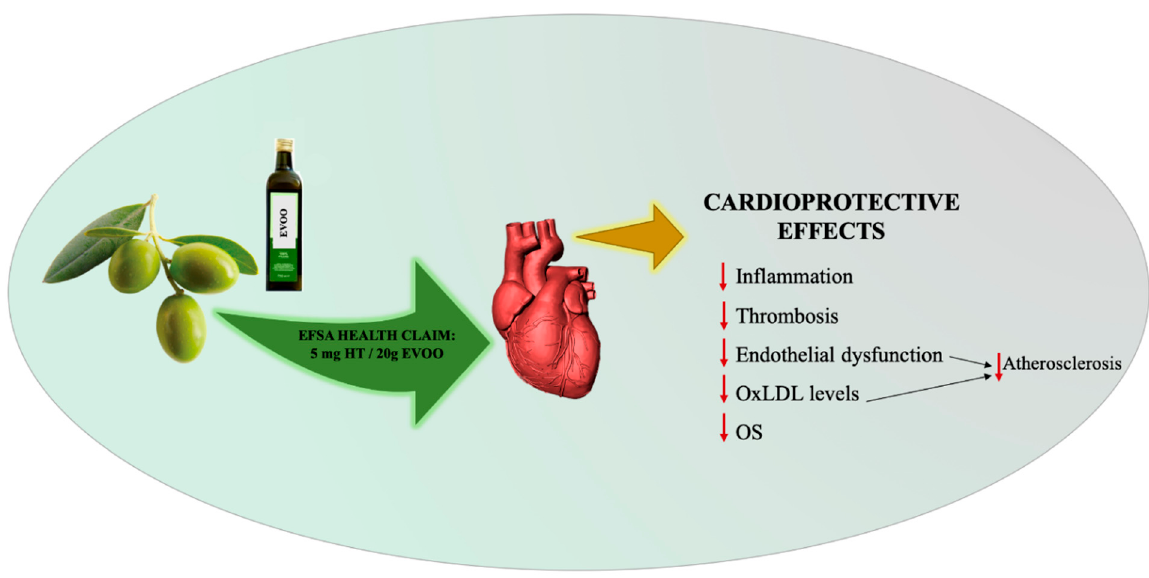
Figure 4. EVOO and its cardioprotective action on the CV system. EVOO, Extra-virgin olive oil; HT, hydroxytyrosol; OxLDL, oxidized LDL; OS, oxidative stress .